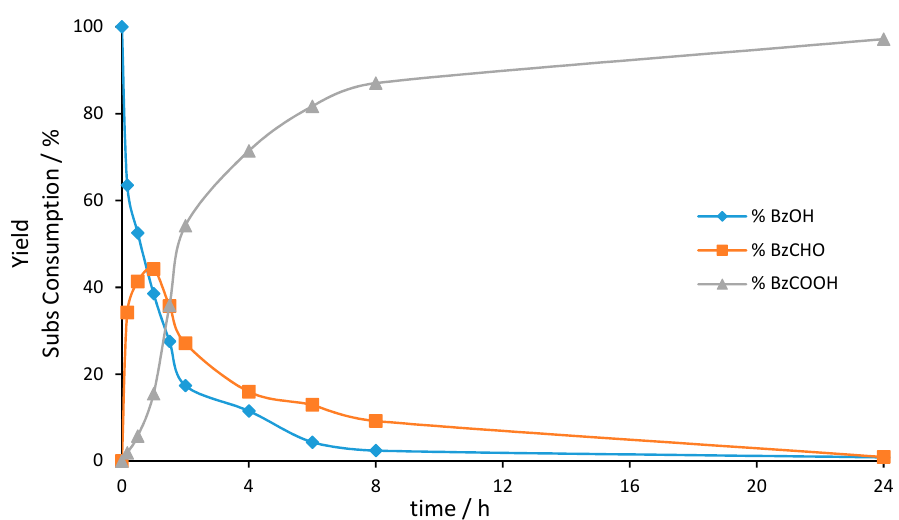
Figure 6. Catalytic oxidation of BnOH with γ -Fe 2 O 3 NPs with TBHP 200%.